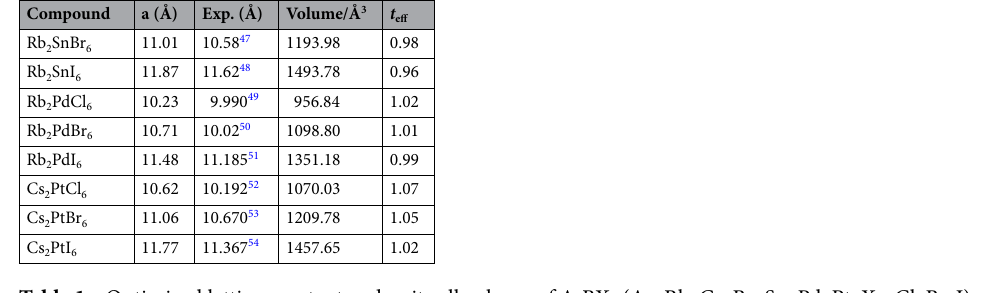
Table 1. Optimized lattice constant and unit cell volume of A 2 BX 6 (A = Rb, Cs; B = Sn, Pd, Pt; X = Cl, Br, I) using the PBE functional.